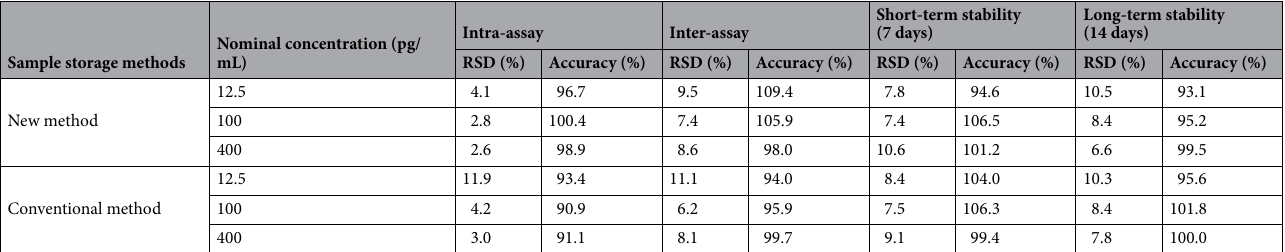
Table 2. Intra- and inter-day accuracy and precision, and stability of